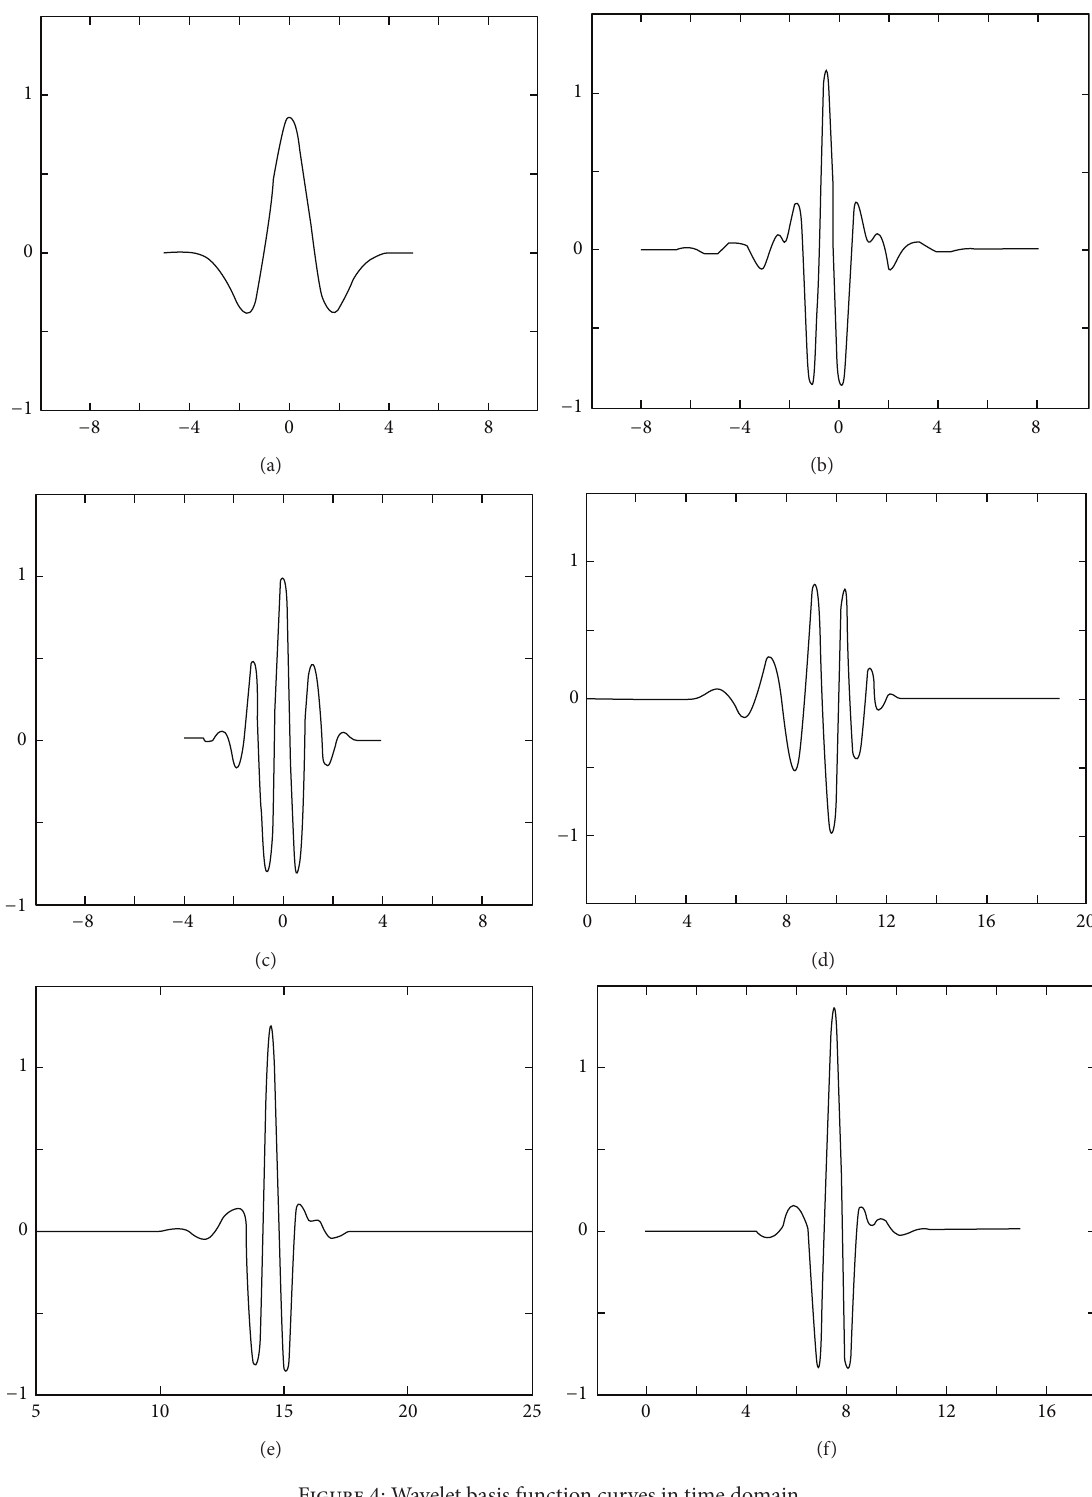
Figure 4: Wavelet basis function curves in time